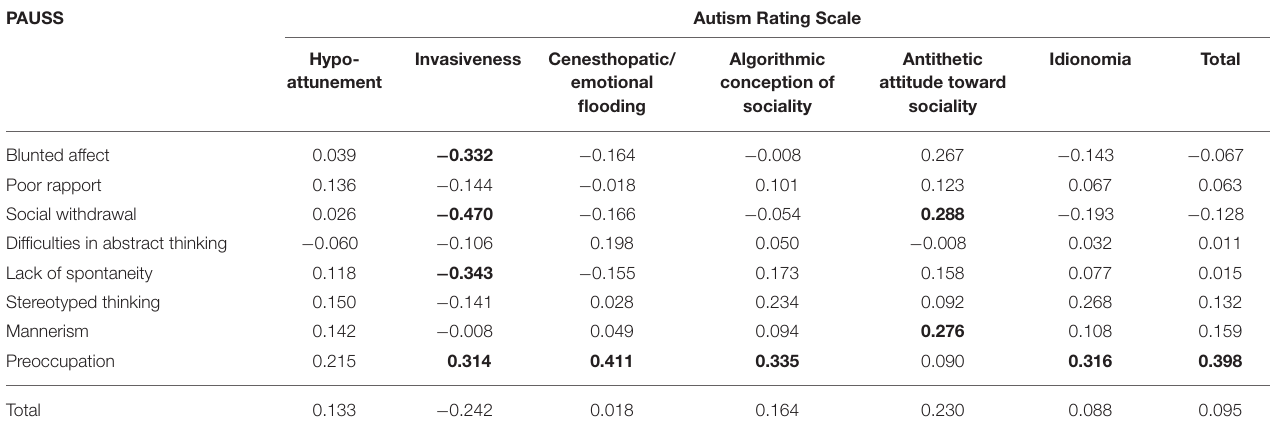
TABLE 4 | Correlation coefficients between Autism Rating Scale and PANSS autism severity score (PAUSS).